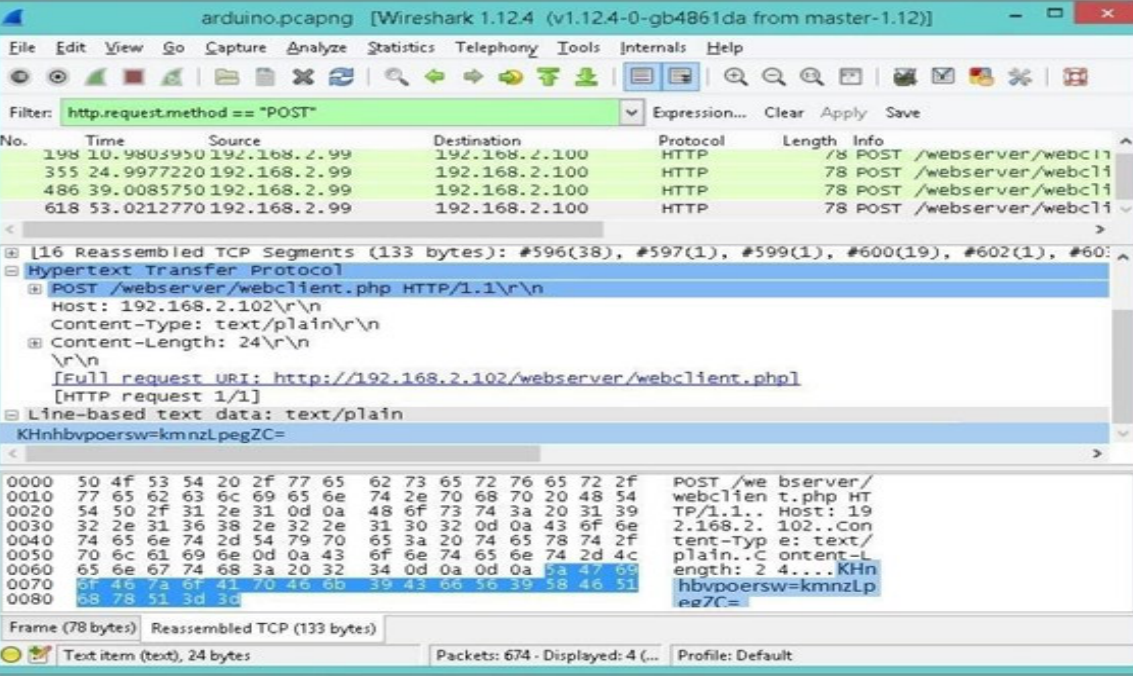
Figure 11. Captured Packet from IoT